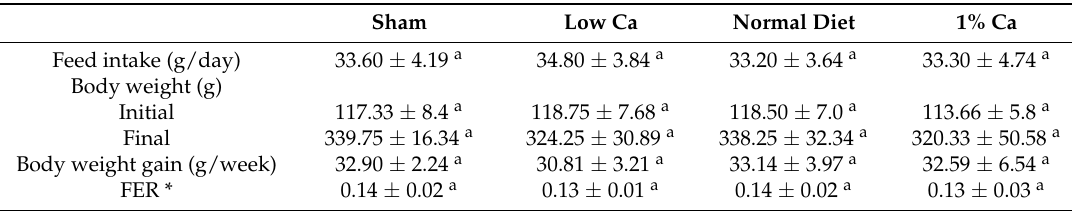
Table 2. Bodyweight and food intake.